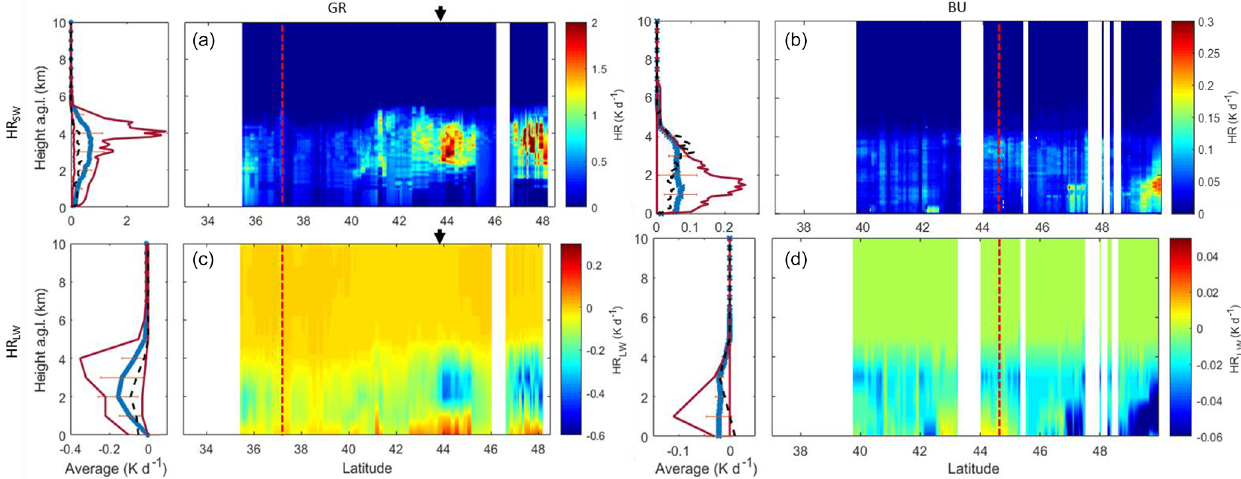
Figure 10. Averaged profiles (blue lines) showing their standard deviation (orange error bars), and curtain plots of the HR profiles along the CALIPSO track for the SW (a, b) and LW (c, d) for the GR (a, c) and BU (b, d) cases. The dashed red vertical lines represent the location of the EARLINET stations. The red solid lines show the profiles corresponding to minimum and maximum AOD, and the dashed black lines represents the profiles above the ground-based sites. For GR, the black arrow above panel (a) indicates the latitude where the surface shifts from land to